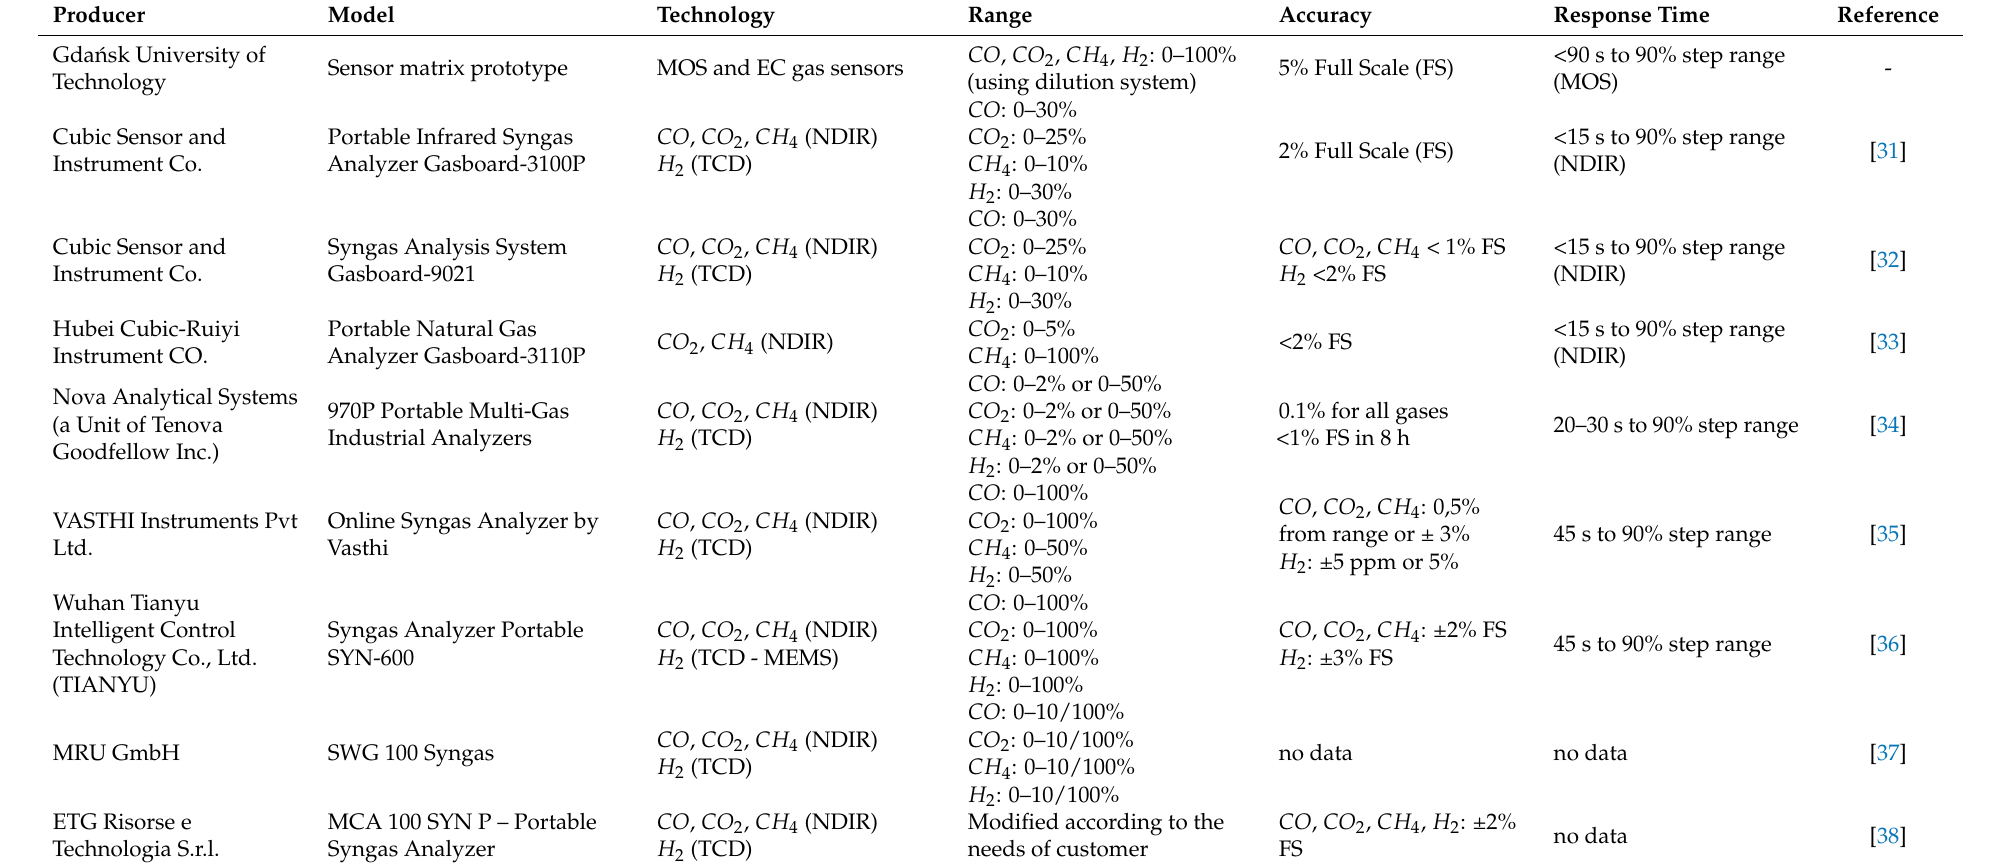
Table 6. The comparison of the constructed sensor matrix with commercially available